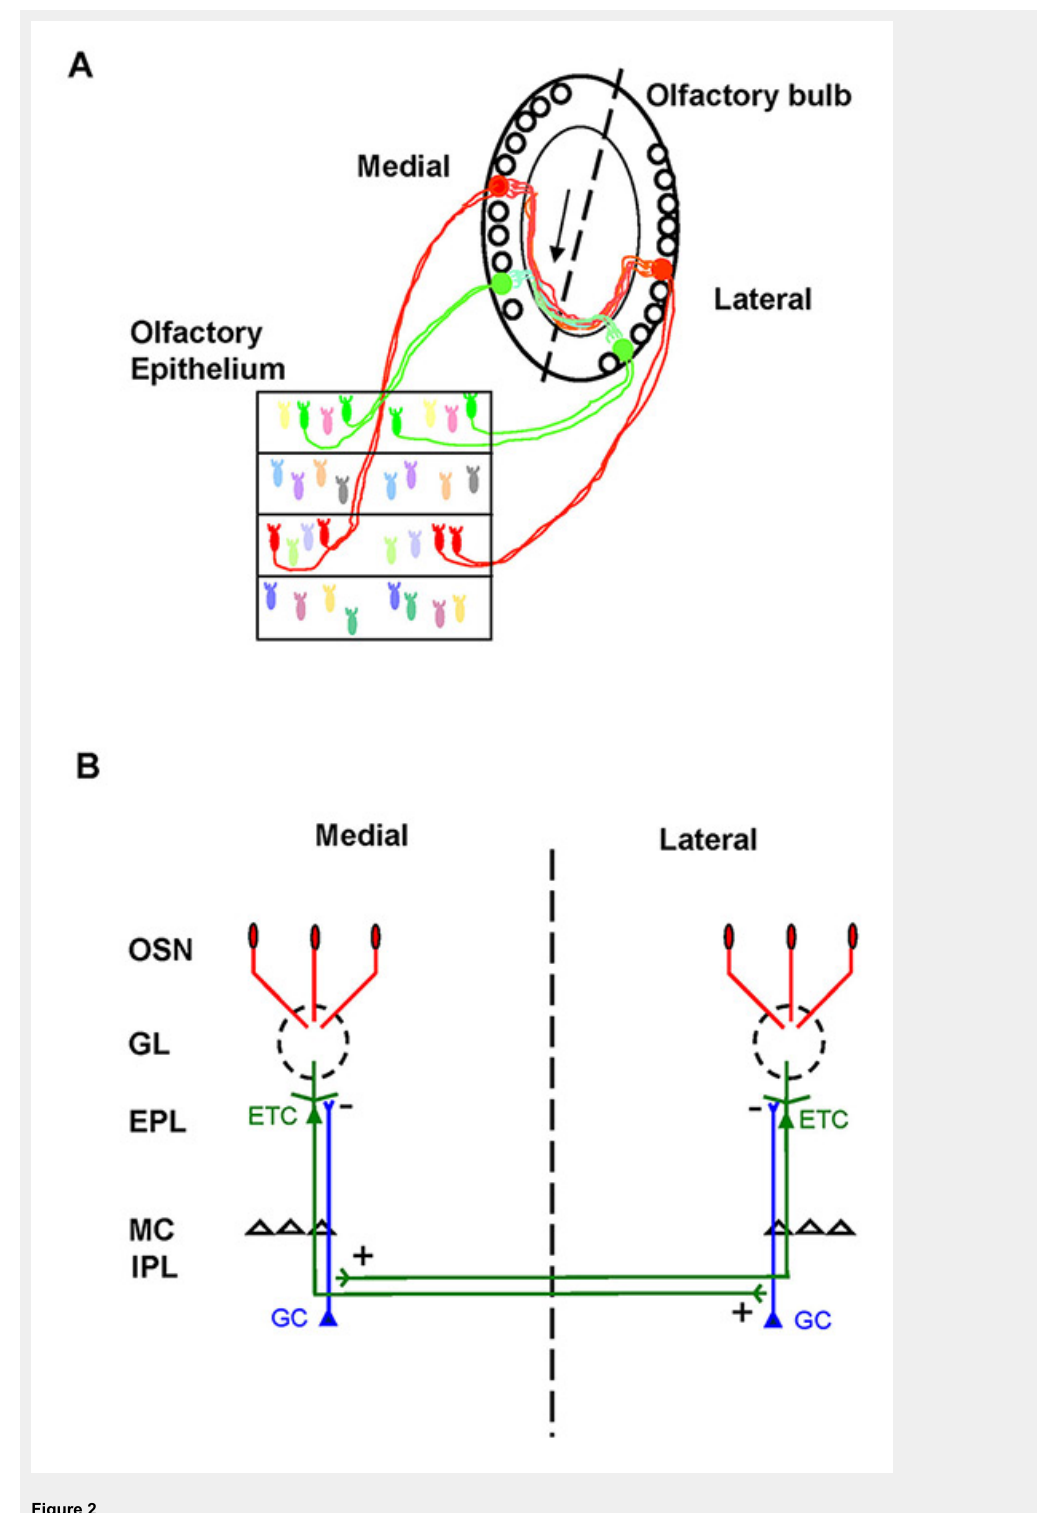
Figure 2 Schematic of neuronal wiring in the olfactory bulb (OB). A. Olfactory sensory neurons (OSNs) expressing the same odorant receptor (green and red) converge to form glomeruli on the medial and on the lateral side of each olfactory bulb. Glomeruli receiving axons expressing the same odorant receptor (OR) (i.e. homologous glomeruli) are specifically and reciprocally connected by the intrabulbar link, related to external tufted cells (arrow). Dashed line indicates the line of symmetry between the two mirror-symmetric maps in horizontal sections (Lodovichi et al., 2003 [27]). B. Schematic of the intrabulbar connections between homologous glomeruli. Briefly, external tufted cells (ETC) connected to a given glomerulus form an axonal projection in the internal plexiform layer (IPL) precisely underneath the homologous glomerulus, on the opposite side of the OB. In the IPL, ETC form excitatory synapses with the granule cells, the major inhibitory interneurons in the OB. This connection is reciprocal. EPL = external plexiform layer; GC = granule cells; GL = glomeruli; MC = mitral